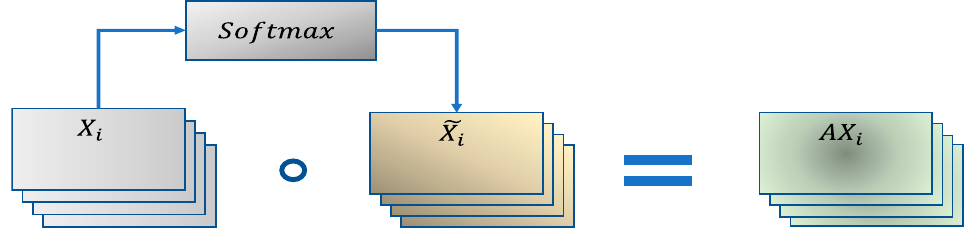
Figure 6. Channel weight diagram.